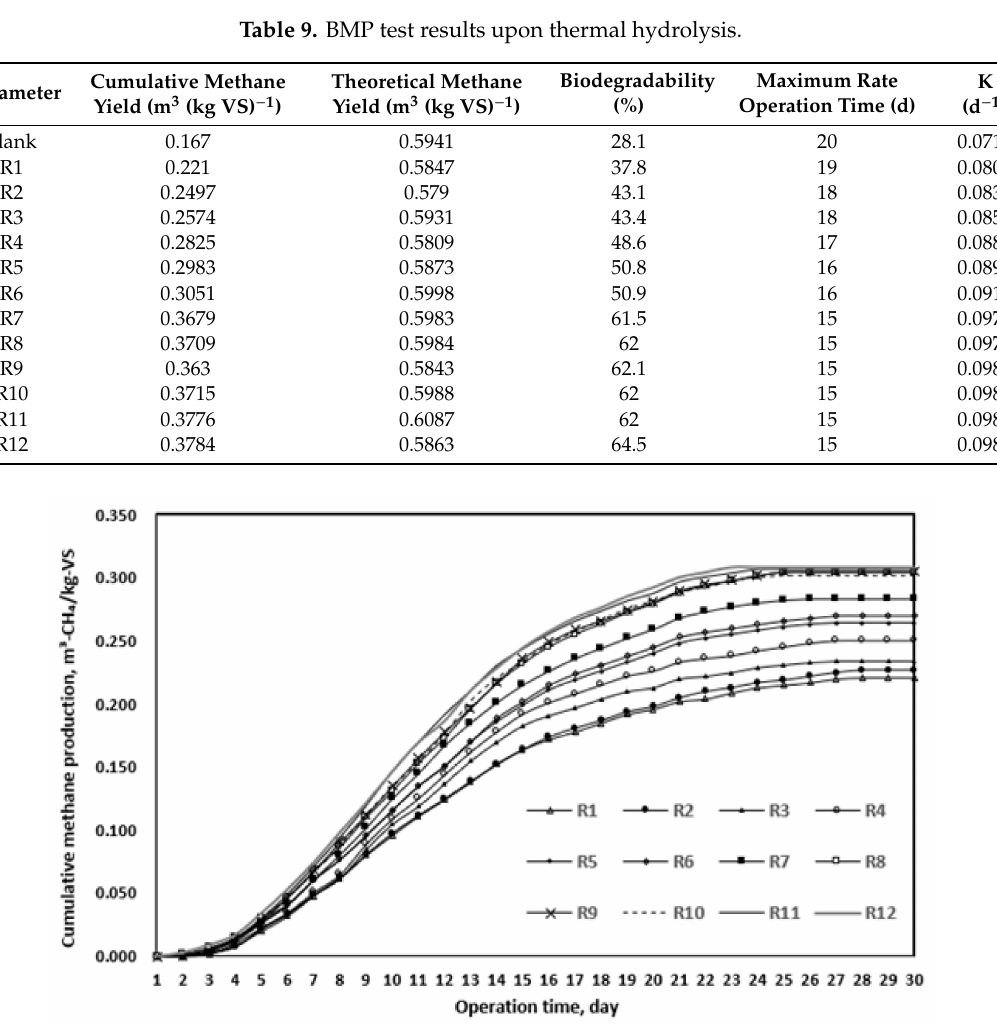
Figure 4. BMP test results after thermal hydrolysis in various reactors